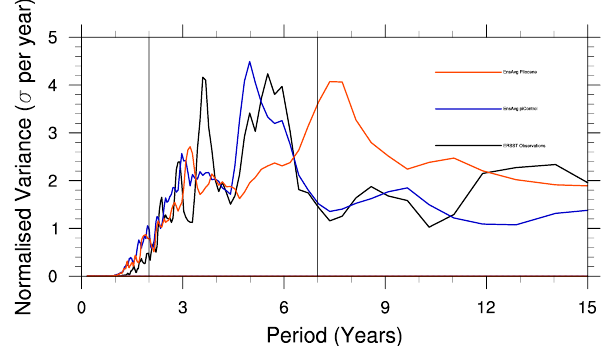
Figure 2. The ensemble average power spectra of the Niño 3.4 sea surface temperature anomalies.